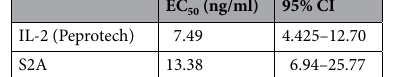
Table 1. Comparison of ELISA binding